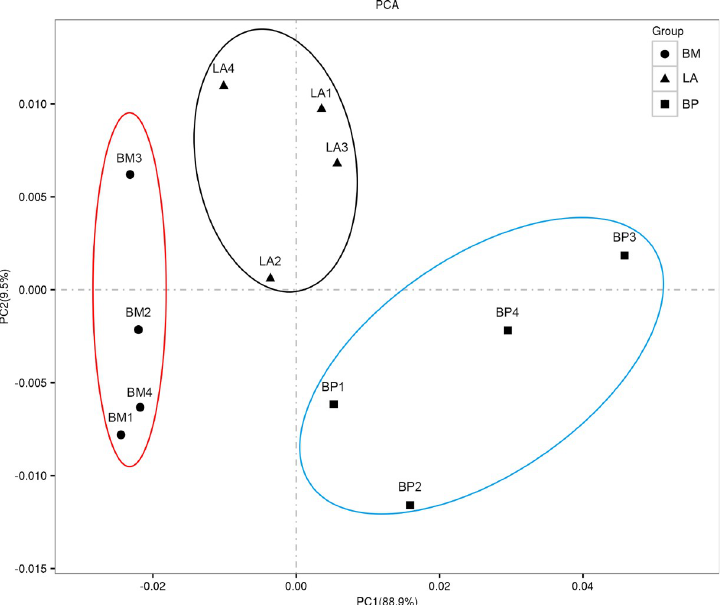
Fig 1. Principal component analysis (PCA) of sample relationship. Correlations between 12 hypothalamic sample mapped onto first two principal components of PCA analysis based on genome-wide expression profiles. Triangle nodes standard for sample of egg-laying anaphase (LA), square nodes for sample of brooding prophase (BP), circle nodes for sample of brooding metaphase